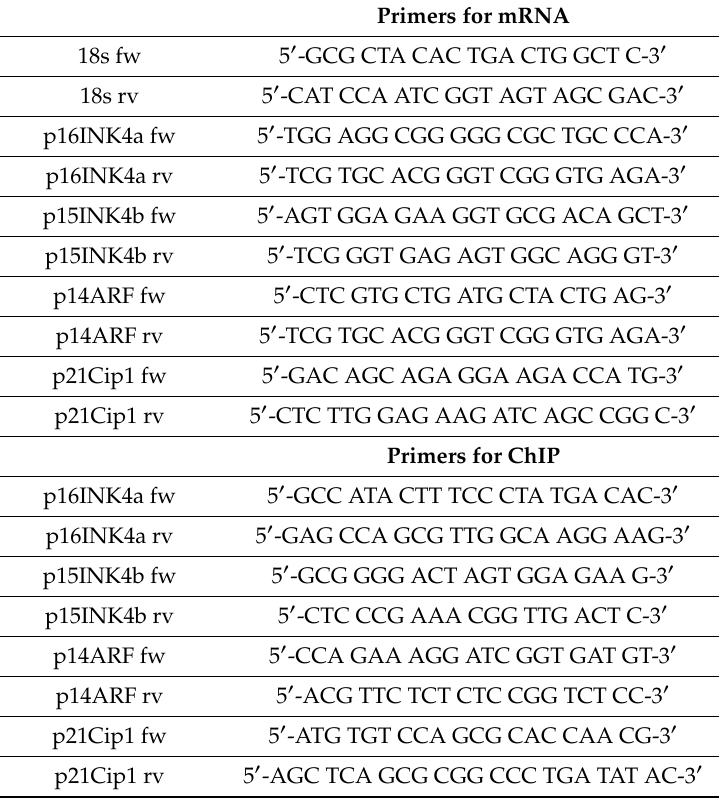
Table 1. Complete list of DNA oligonucleotides. On the left is shown the primer identification tag (ID) containing the name of gene; on the right, the corresponding DNA